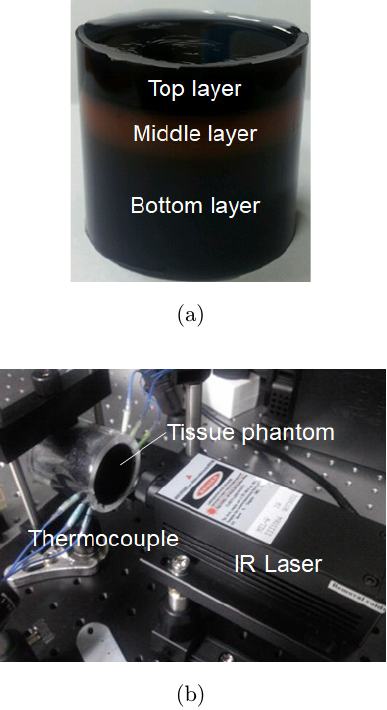
Fig. 2. (a) Multilayer agar gel phantom and (b) Sample holder with thermocouples inserted into the tissue phantom irradiated by infrared laser.